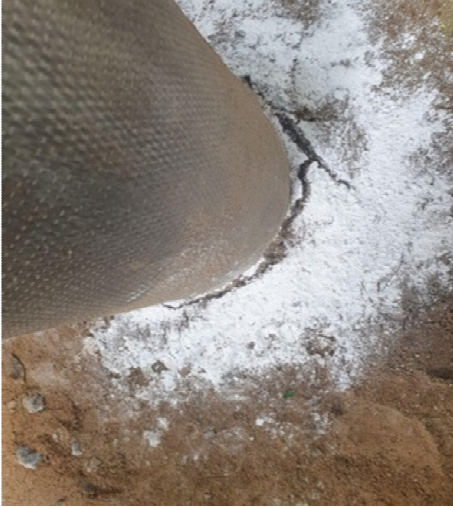
Figure 15. Gap between pile and soil.